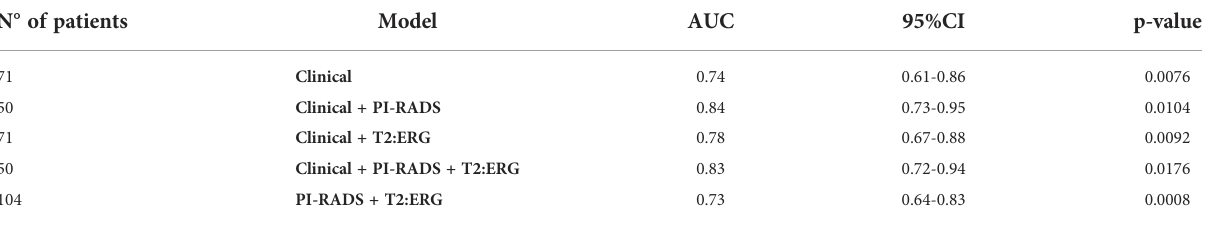
AUC, Area under the ROC Curve; CI, con fi dence interval; PI-RADS, Prostate Imaging Reporting and Data System; T2:ERG,